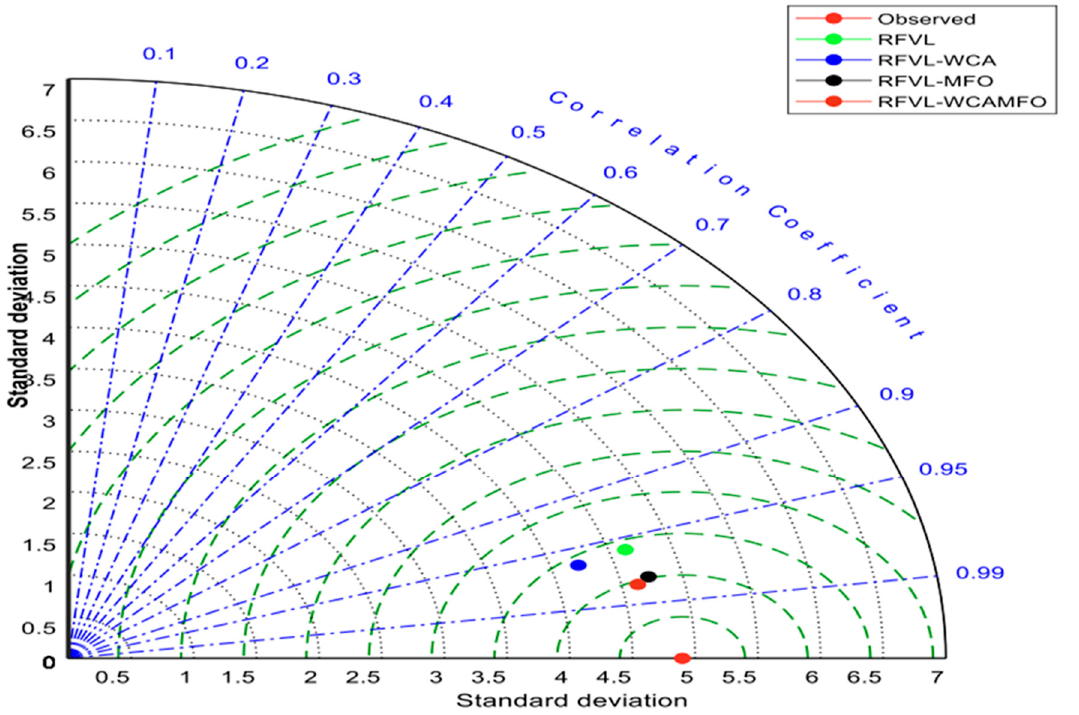
Figure 8. Taylor diagrams of the estimated Temperature by different RVFL-based models in the test period for daily time scale.